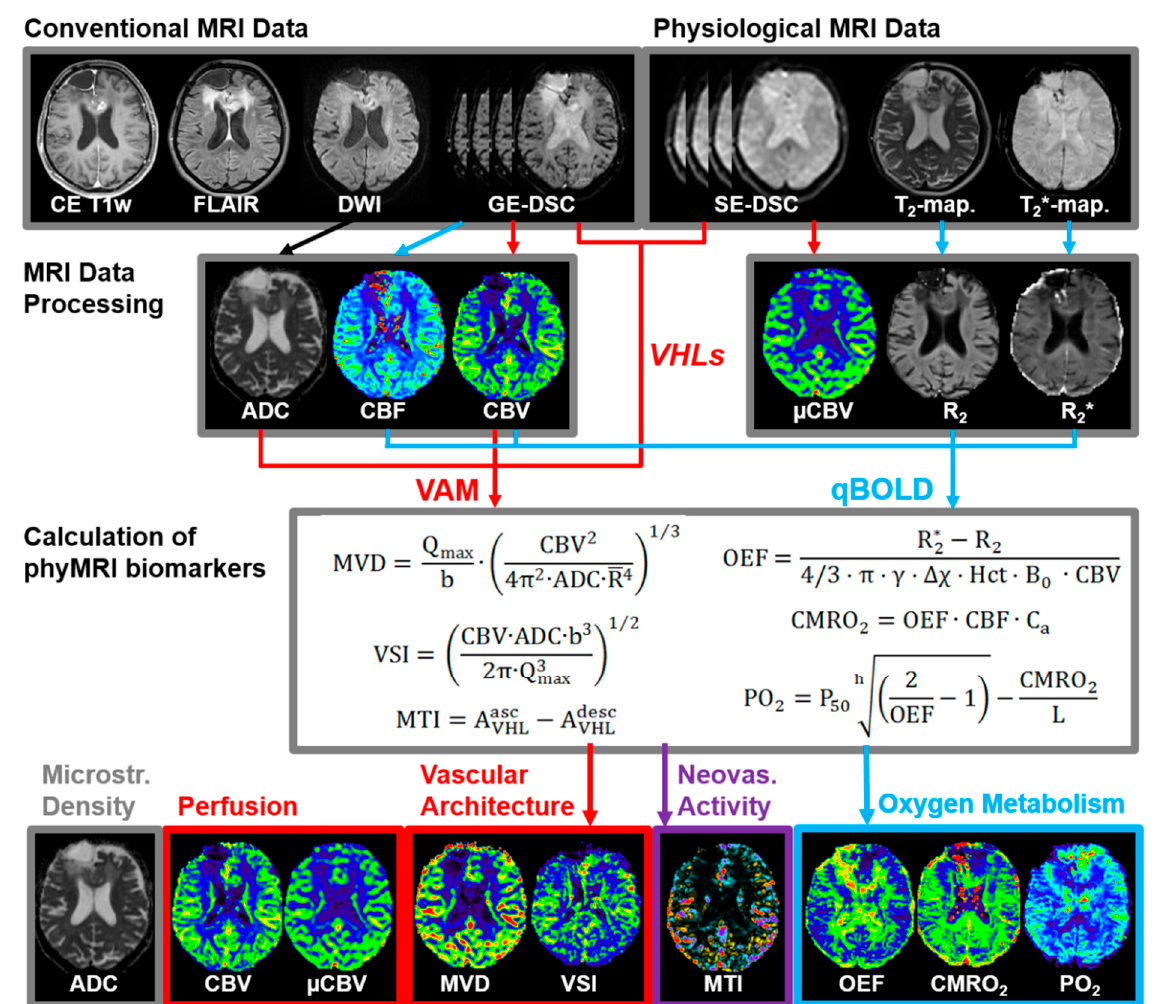
Figure 1. The pipeline for MRI data processing and calculation of MRI biomarker maps (adapted from [42]).